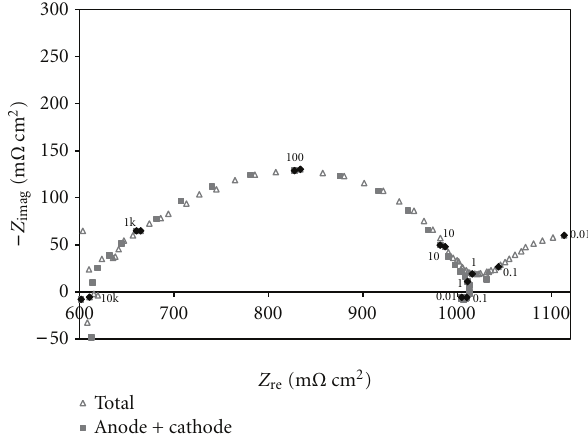
Figure 3: Nyquist plot of the total cell compared with the sum of the individual anode and cathode spectra for a button cell operating at 750 ◦ C and 175 mAcm − 2 and fed with 3% H 2 O and balance H 2 . A large low-frequency arc is unique to the measured total-cell impedance.